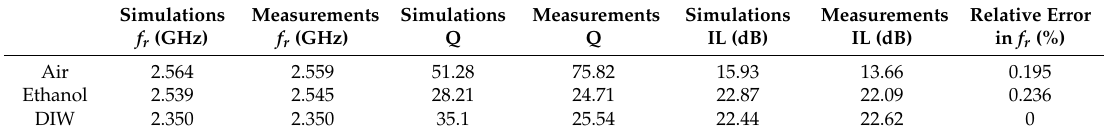
Table 2. Comparison of simulations and measurements. The resonant frequency ( f r ), Q-factor, and insertion loss (IL) for the three cases (air, ethanol, and DIW) are